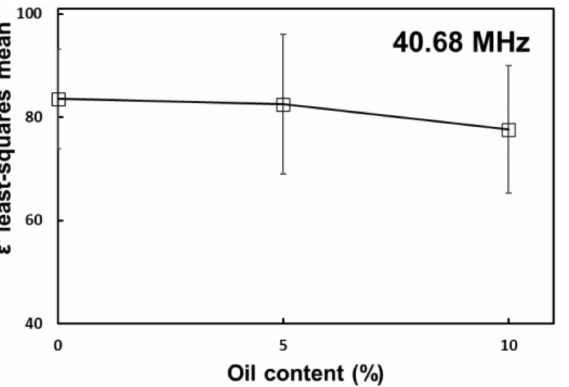
Figure 2. Main effect of oil content on the dielectric constant of tomato homogenate at 40.68 MHz. Error bars correspond to standard deviations.